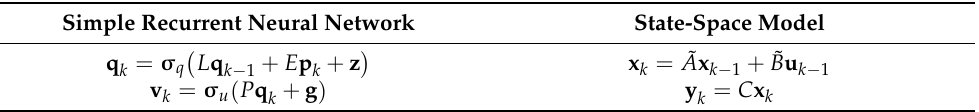
Table 2. Summary of state–space model and Simple Recurrent Neural Network definition. Simple Recurrent Neural